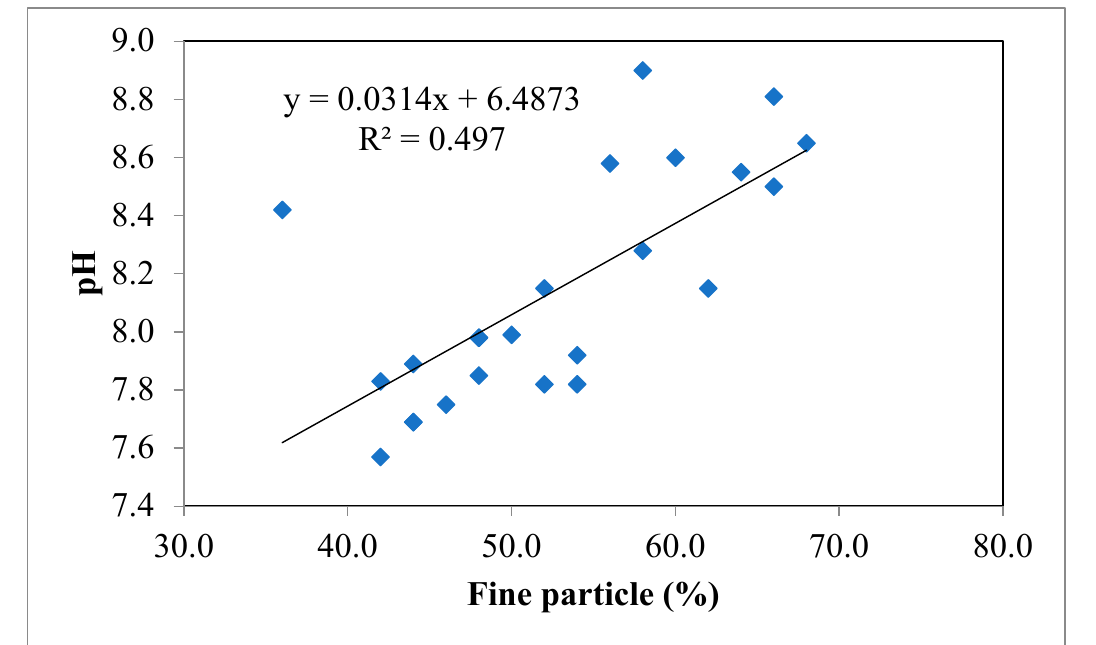
Figure 5. Relationship of fine particle (clay plus silt) with soil pH under different land use systems in semi-arid climatic conditions . Table 2. Annual, seasonal and runoff generating rainfall (mm) and runoff producing events during the experimental period (2011-2019).